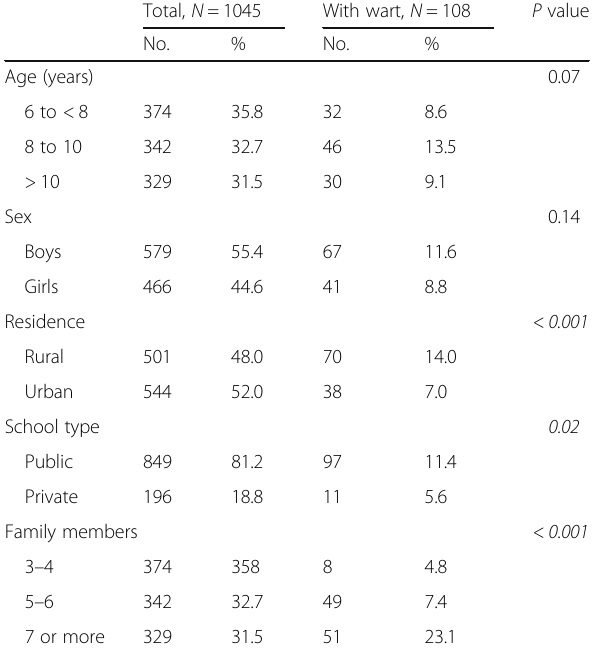
Table 1 Relation between wart infection and